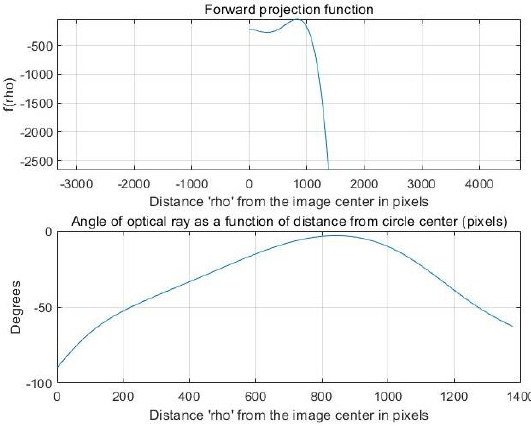
Figure 21. Calibration result chart.